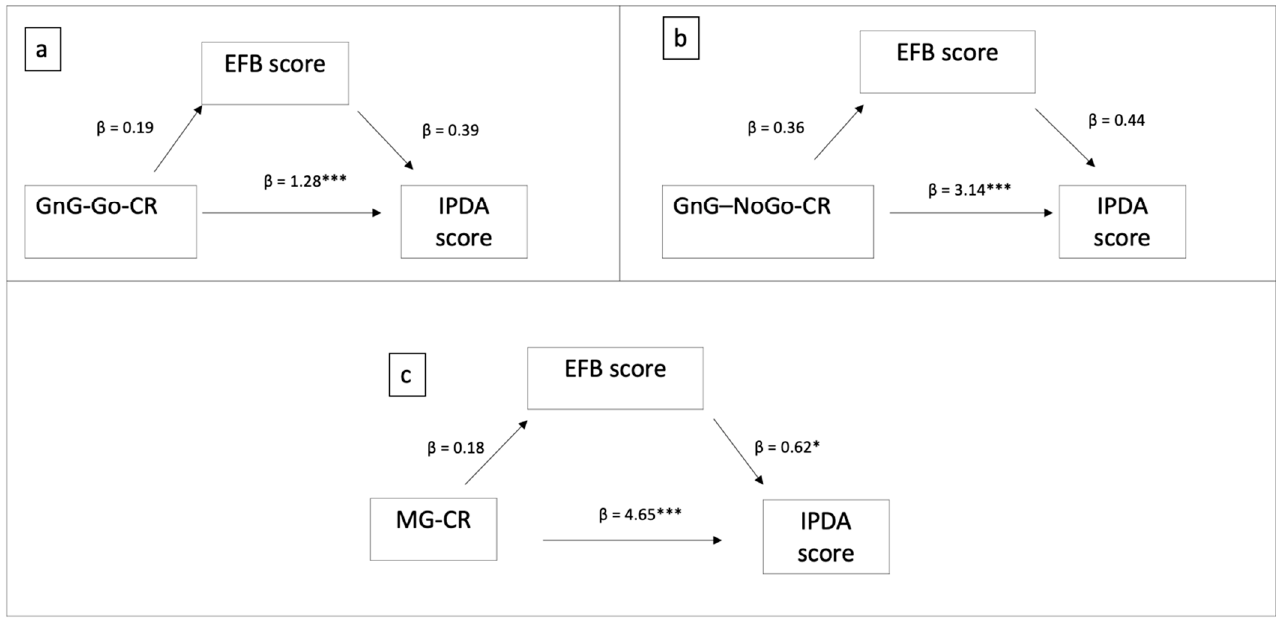
Figure 5. Direct and indirect effect of the EFs (( a ): correct responses at Go-NoGo Test Go condition; ( b ): correct responses at Go-NoGo Test NoGo condition; ( c ): correct responses at Mr. Giraffe test) on the IPDA score via the Executive function behavior scores. * p < 0.05; *** p < 0.001